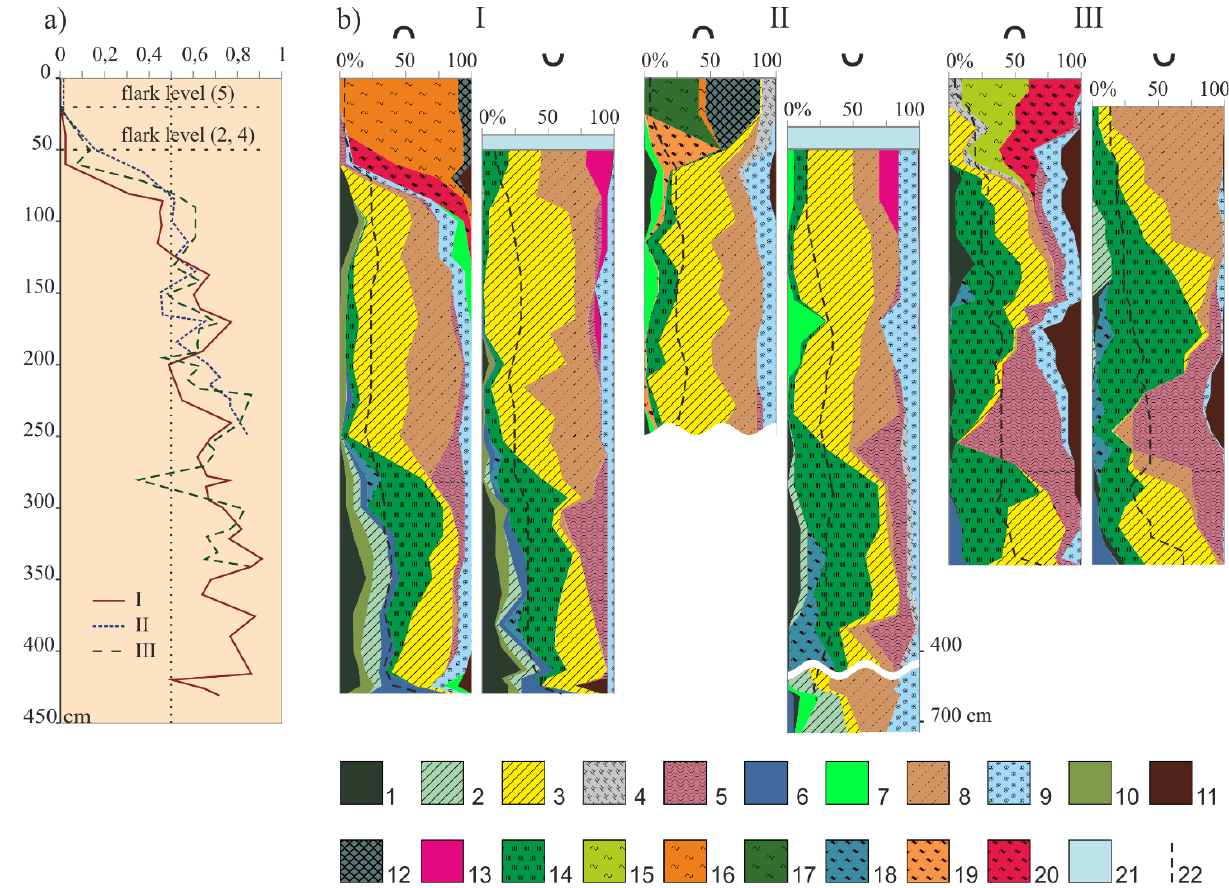
Figure 3. Macrofossil compositions of string and flark peat deposits. a) Similarity (Sørensen-Czekanowski's index) of the macrofossil compositions of string and flark peat deposits from three sample plots (for above- flark levels, data for flark-surface peat are used). b) Macrofossil compositions of string (ᴖ) and flark (ᴗ) peat deposits: I = Sample Plot 2; II = Sample Plot 4 (the uppermost 250 cm of a > 650 cm core of string peat was analysed, more detail is given in Figures 4 and 5); III = Sample Plot 5. Macrofossils (1–20): 1 = Betula ; 2 = Carex rostrata ; 3 = Carex spp ( C. lasiocarpa + C. limosa , C. chordorrhiza , C. omskiana ); 4 = Dwarf shrubs; 5 = Eriophorum ; 6 = Equisetum ; 7 = Herbs; 8 = Hypnales ( Scorpidium scorpioides , S. cossonii , Meesia , Calliegon , Warnstorfia , etc.); 9 = Menyanthes ; 10 = Phragmites ; 11 = Pinus ; 12 = Polytrichum + Aulacomium ; 13 = Rhynchospora + Baeothryon ; 14 = Scheuchzeria ; 15 = Sphagnum angustifolium ; 16 = S. fuscum ; 17 = S. russowii ; 18 = S. centrale + S . sect. Subsecunda; 19 = S. teres ; 20 = S. warnstorfii